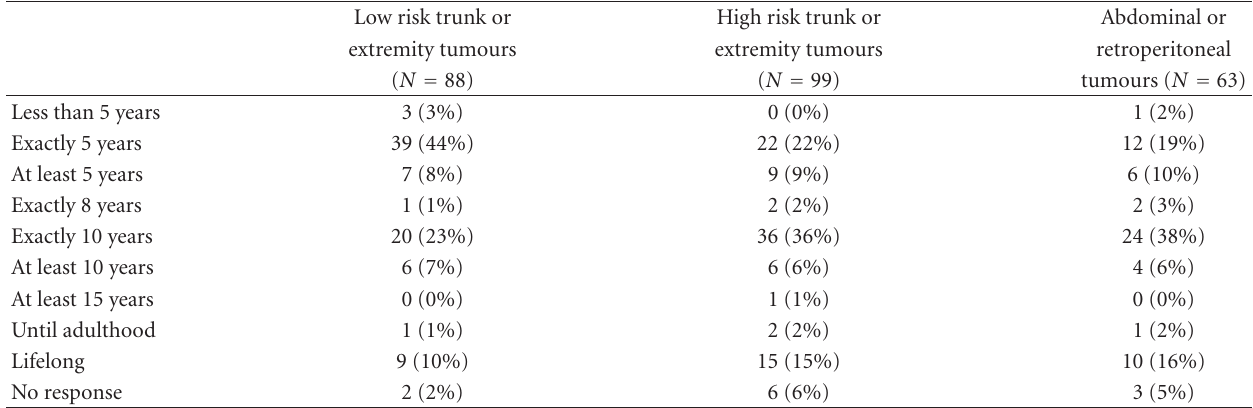
Table 1: Length of follow up after treatment.